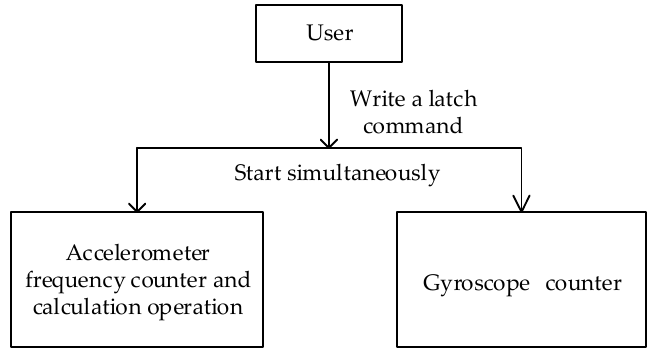
Figure 4. Software design of the synchronous data acquisition module.